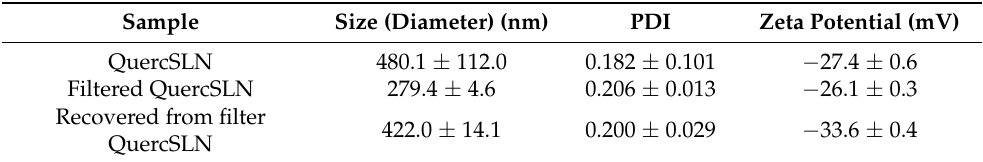
Table 2. Particle size and Zeta potentials for QuercSLNs.